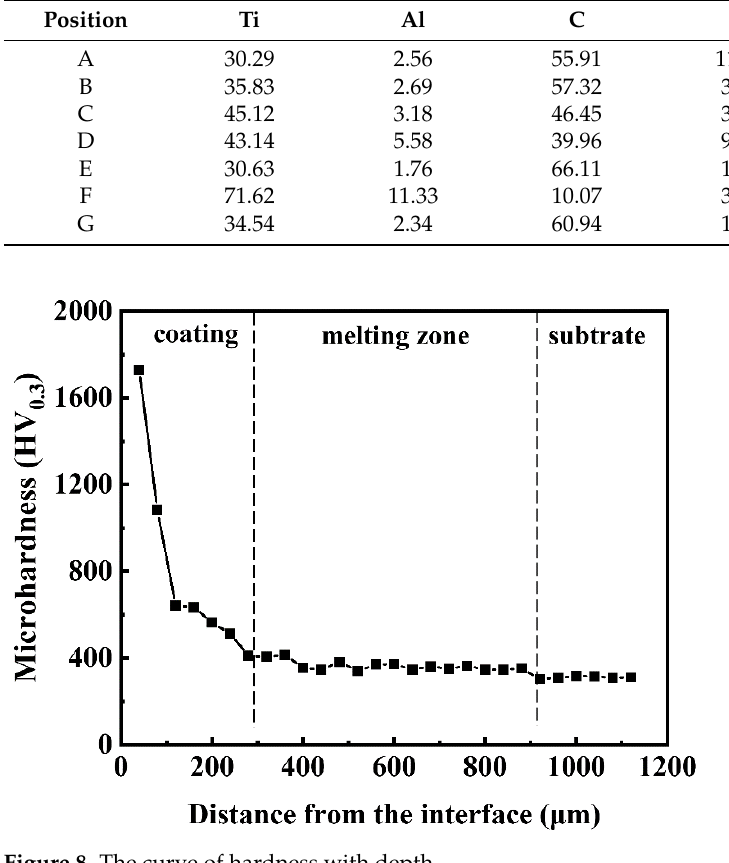
Figure 8. The curve of hardness with depth.